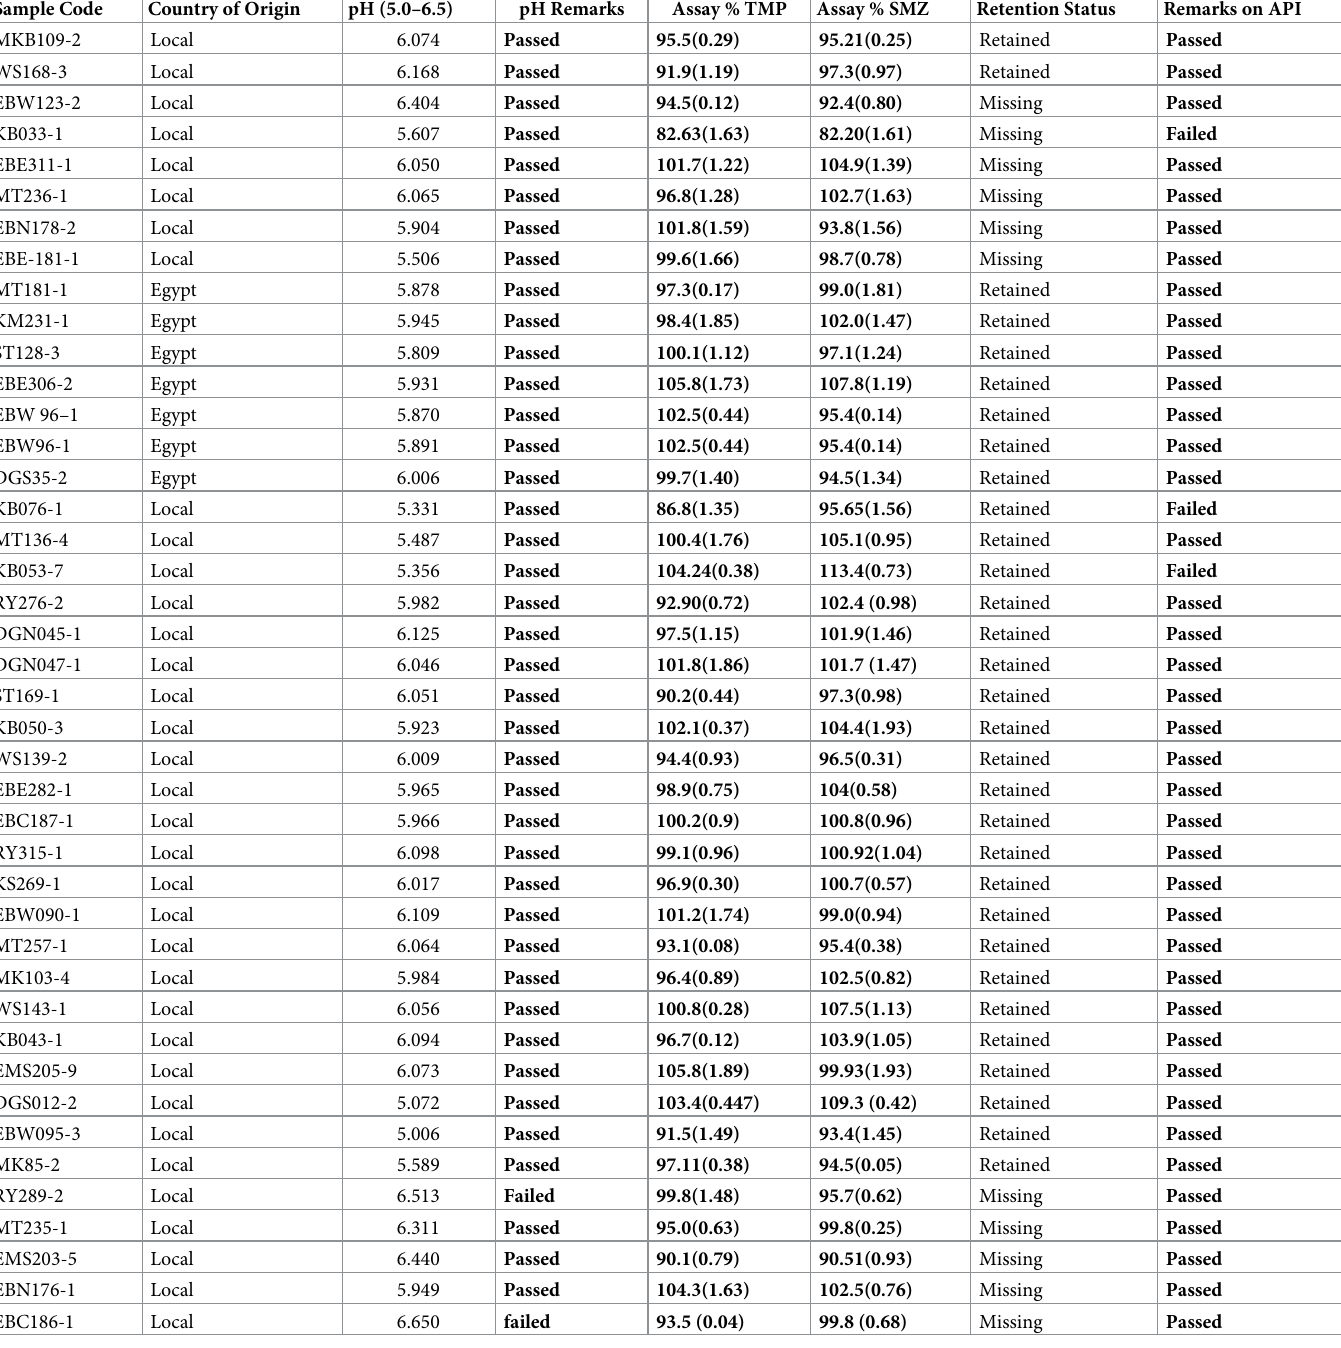
Figure in brackets is Relative Standard Deviation; Trimethoprim and Sulfamethoxazole USP limits: Not less than 90.0% and not more than 110.0% of label claim; 40mg Trimethoprim/ 200mg Sulfamethoxazole per 5